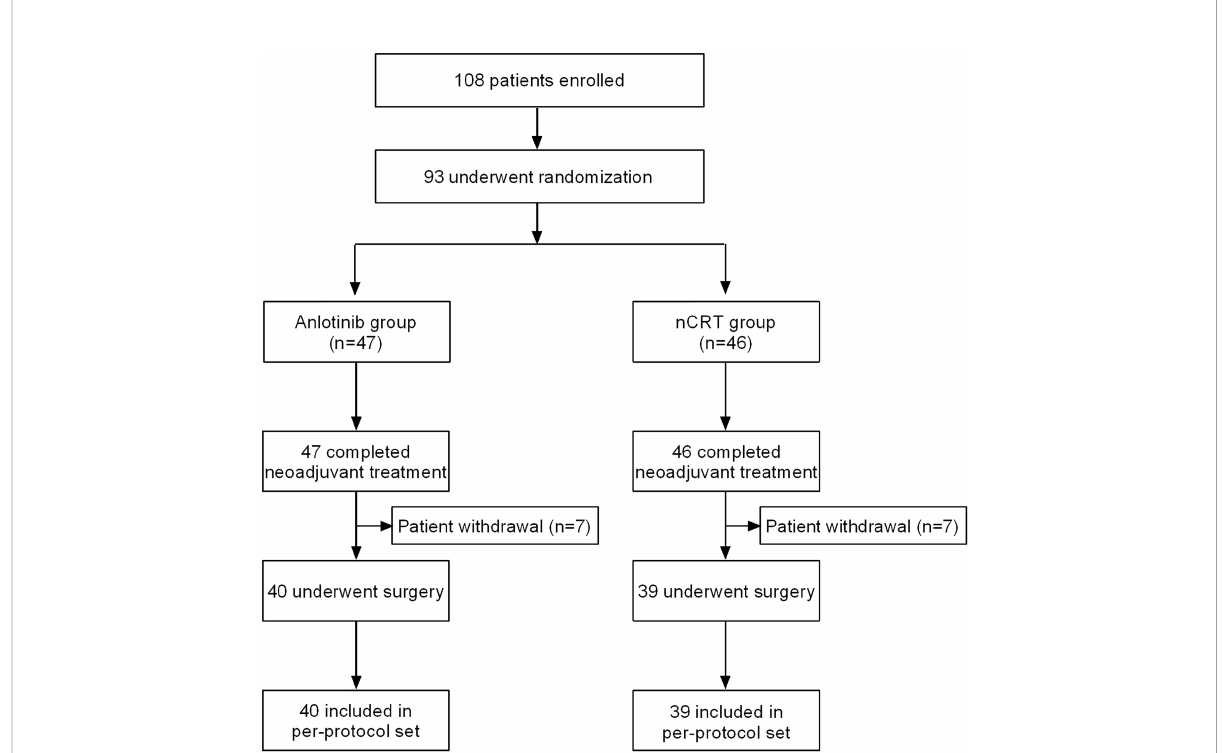
FIGURE 2 Patients fl owchart. Anlotinib group, neoadjuvant Anlotinib combined with chemotherapy; nCRT group, neoadjuvant